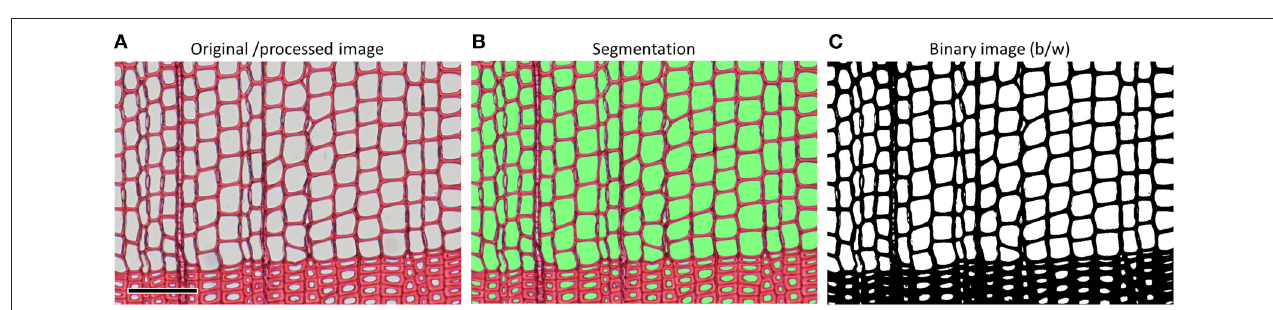
FIGURE 10 | (A) Anatomical image of a Pinus sylvestris sample with (B) visualization of the segmentation threshold by a green mask and (C) the resulting binary image after performing the segmentation, which is the basis for quantifying the anatomical features. Depending on the image-analysis software the segmentation is applied to the original or processed color image, or a gray-scale image resulting from one to several image-processing steps (cf. Figure 9 ). Scale bar = 100 µ